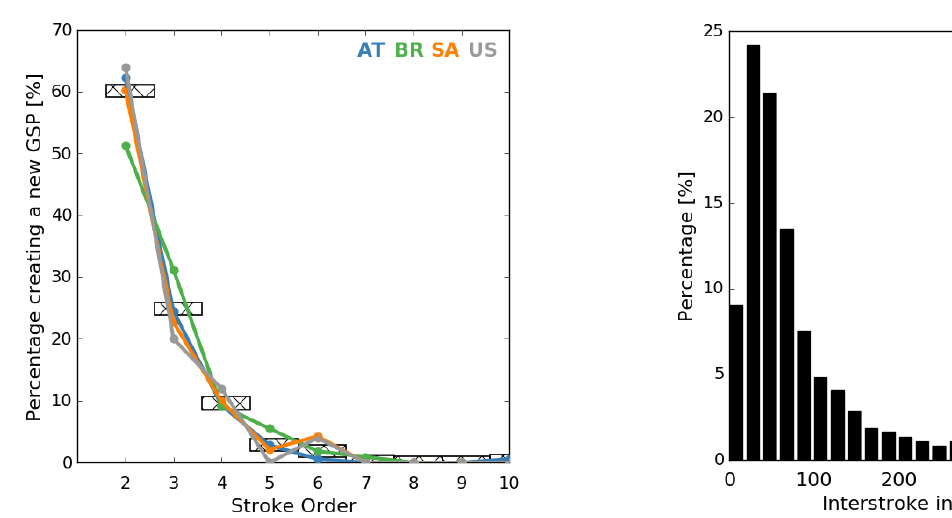
Figure 7. Interstroke time intervals for all subsequent strokes and for the same and new lightning